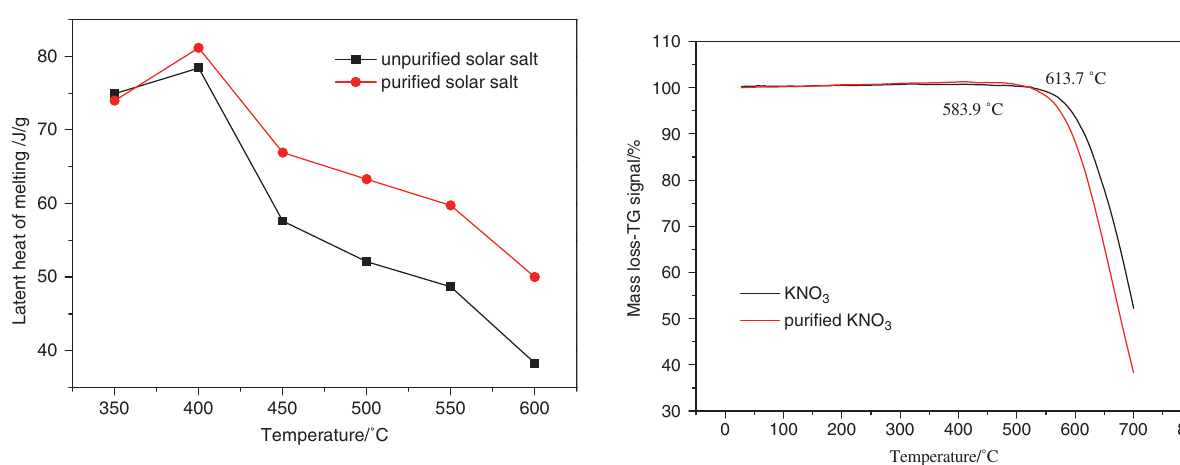
Figure 13: Thermogravimetric measurement results of potassium nitrate molten salt.